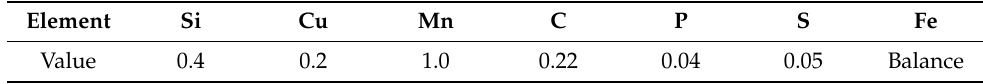
Table 1. Chemical composition of the A441 AISI steel.